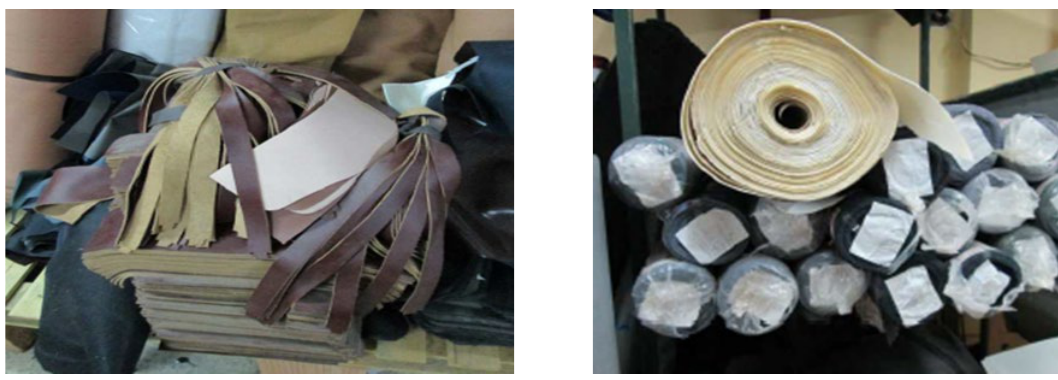
Figure 2. Organizational actions in enterprise - Seiton action (left) and Seiri action